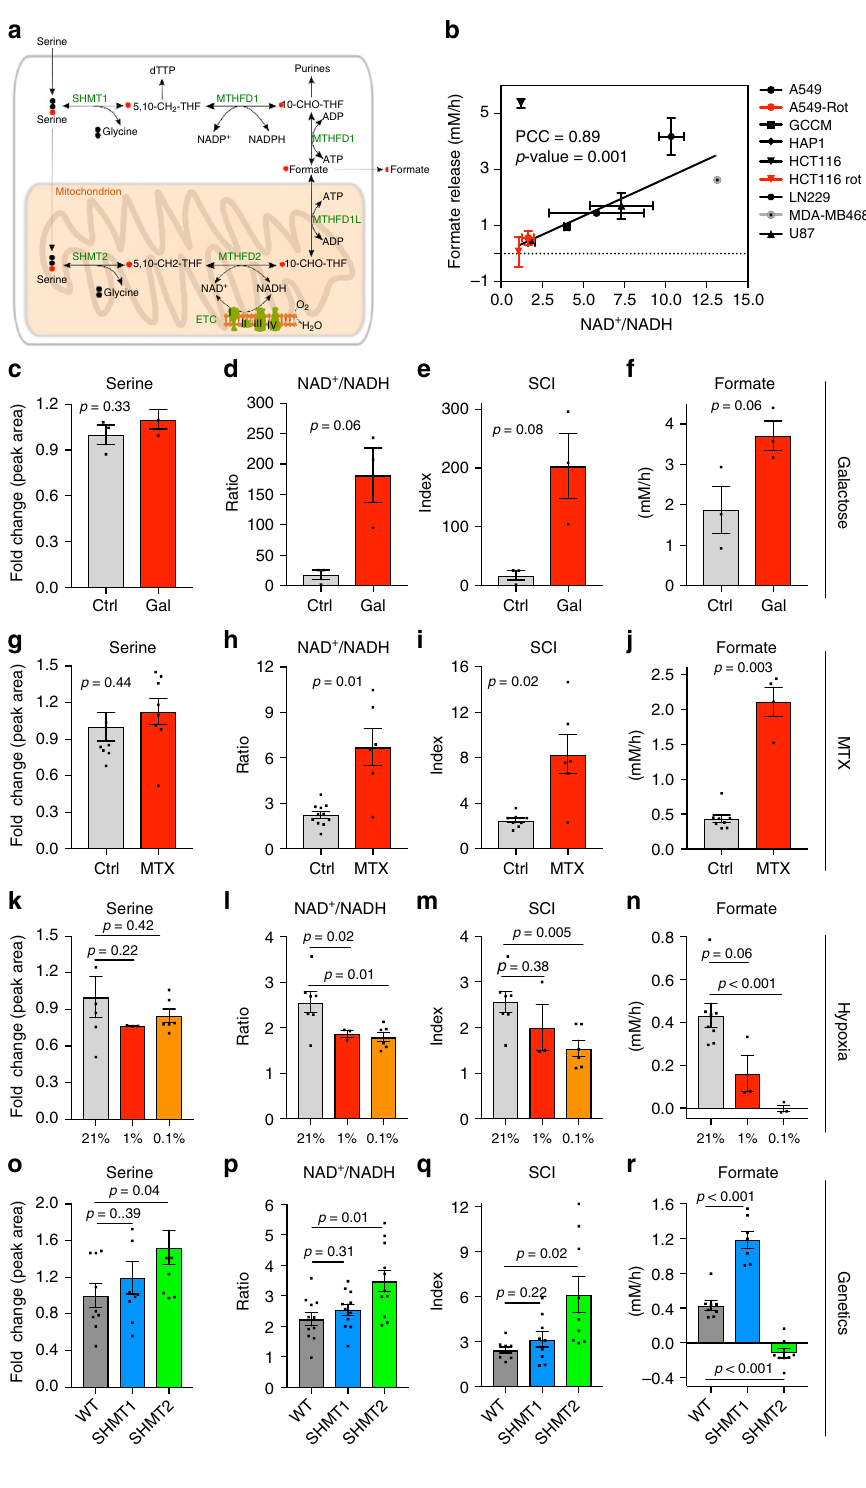
(Fig. 1l: p = 0.02 at 1% and p = 0.01 at 0.1%; Fig. 1m: p = 0.38 at 1% and p = 0.005 at 0.1%; unpaired t -test). This observation con fi rms the expectation that hypoxia shifts cells to a more reduced state. In agreement with the SCI decrease, formate release also decreased signi fi cantly (Fig. 1n: p = 0.06 at 1% and p < 0.001 at 0.1%, unpaired t -test). Taken together the perturbation analyses support our hypothesis that, regardless of the